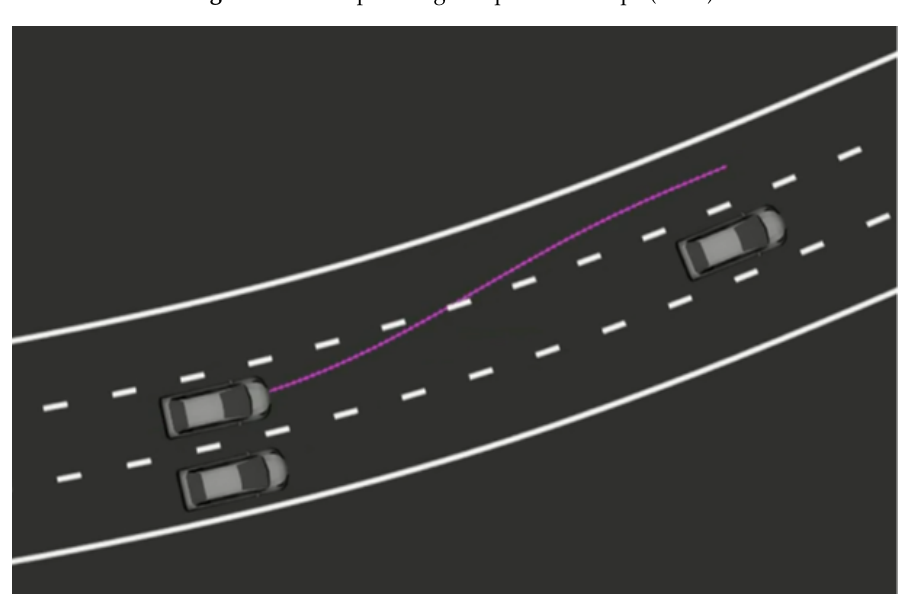
Figure 8. Local planning in